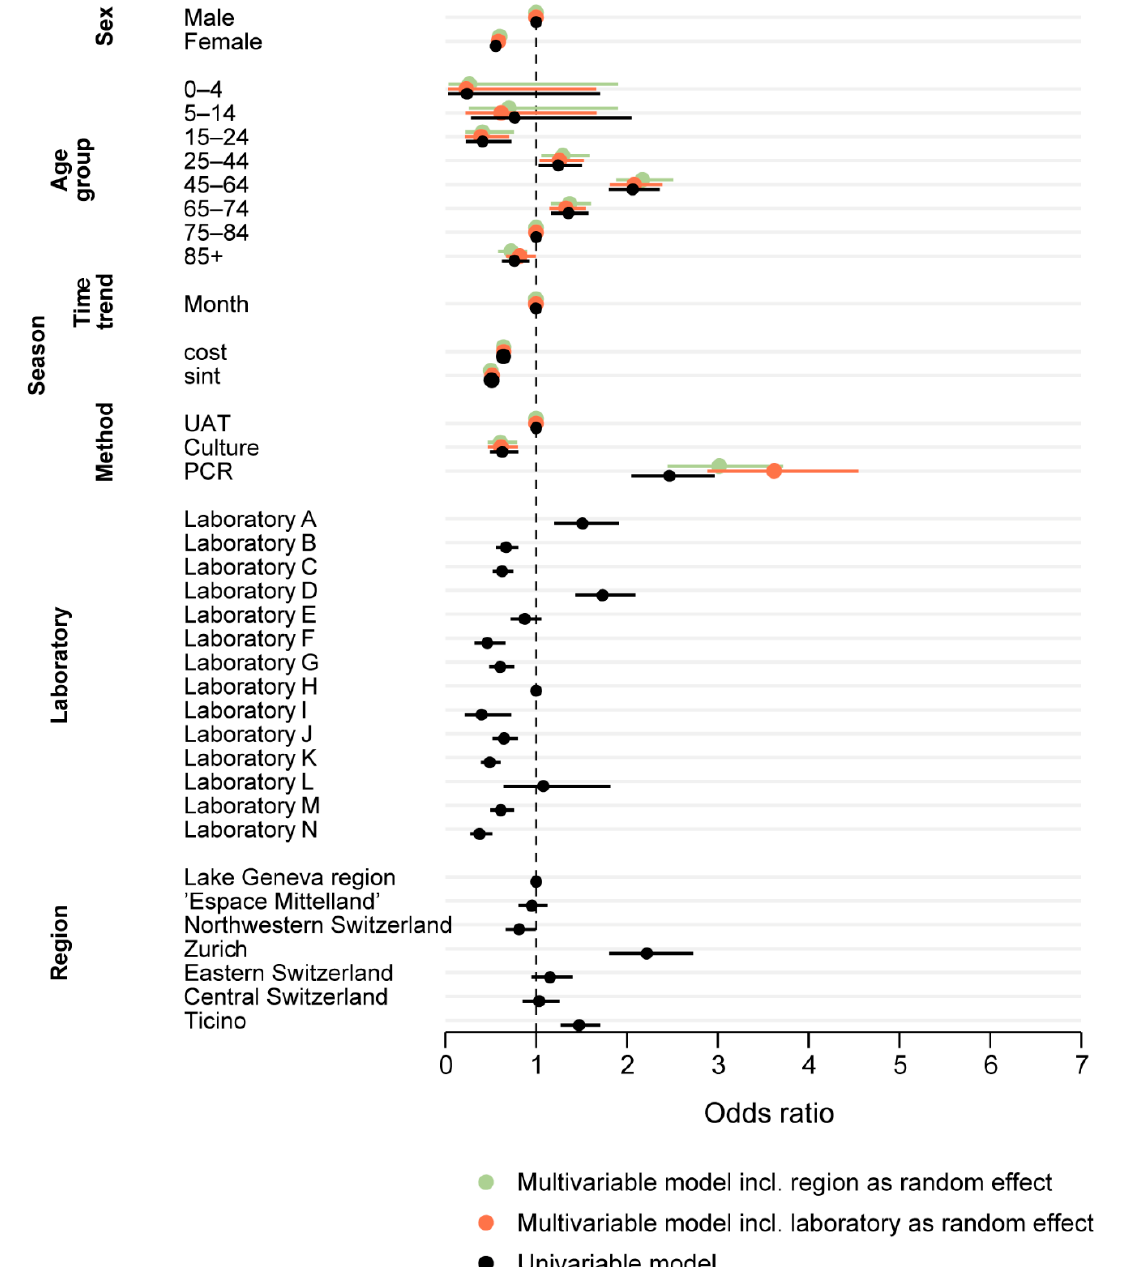
Figure 5. Determinants for a positive test result for Legionella spp. Multivariable mixed-effect logistic regression compared with the univariable regression results for the outcome of having a positive test result for Legionella spp. in Switzerland, 2007–2016.